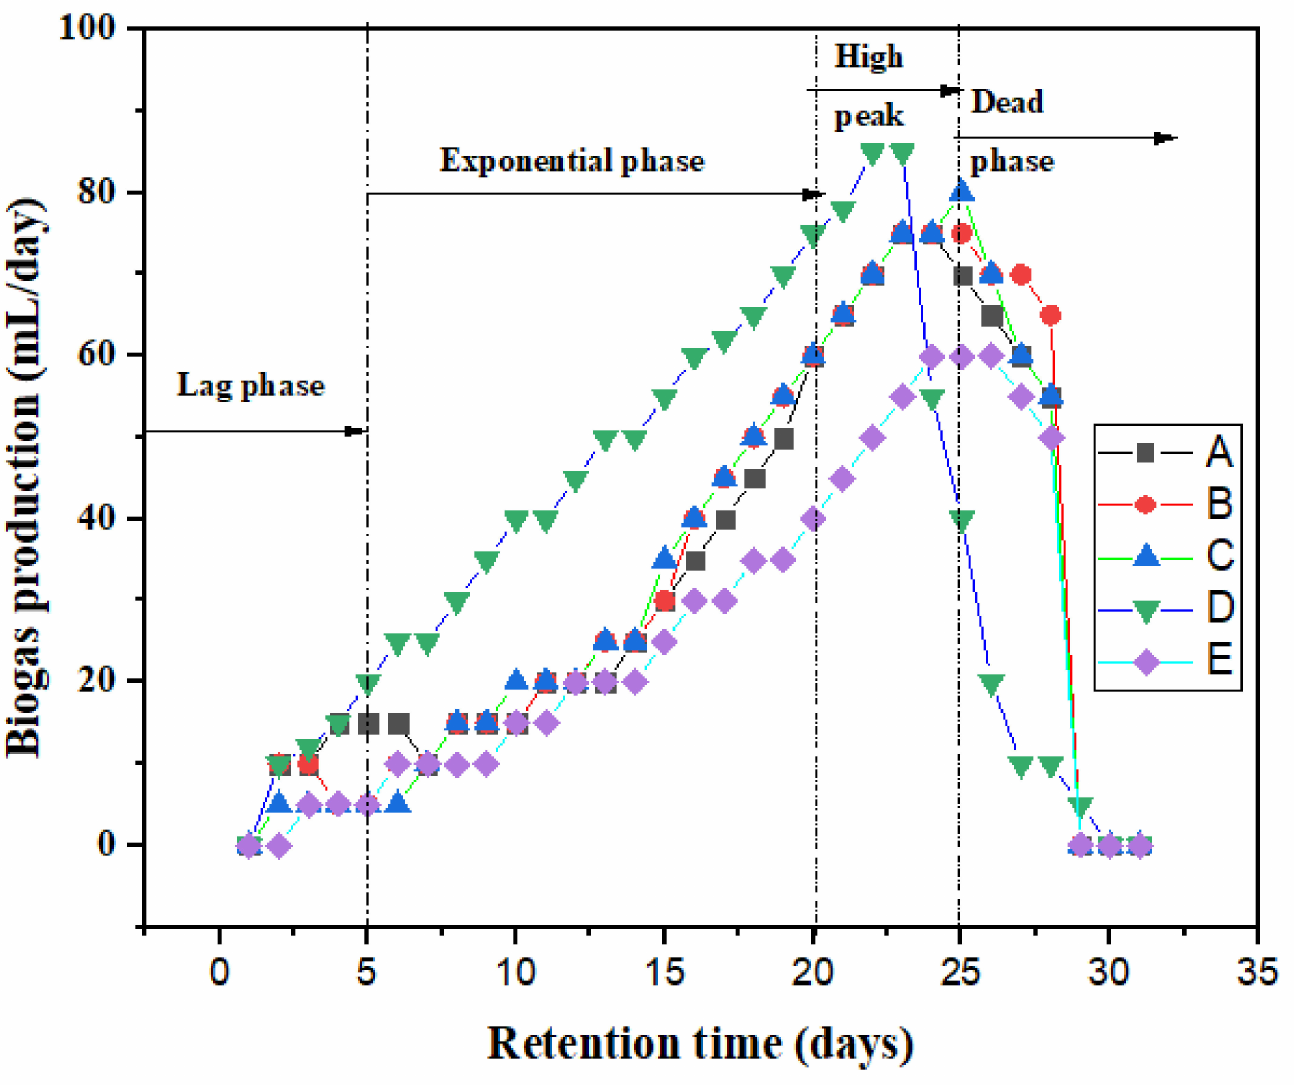
Figure 5. Daily biogas production of bioreactors (A–E) for HRT of 30